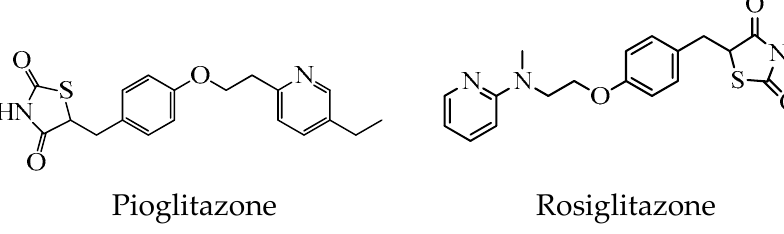
Figure 2. Approved drugs with thiazole scaffold.